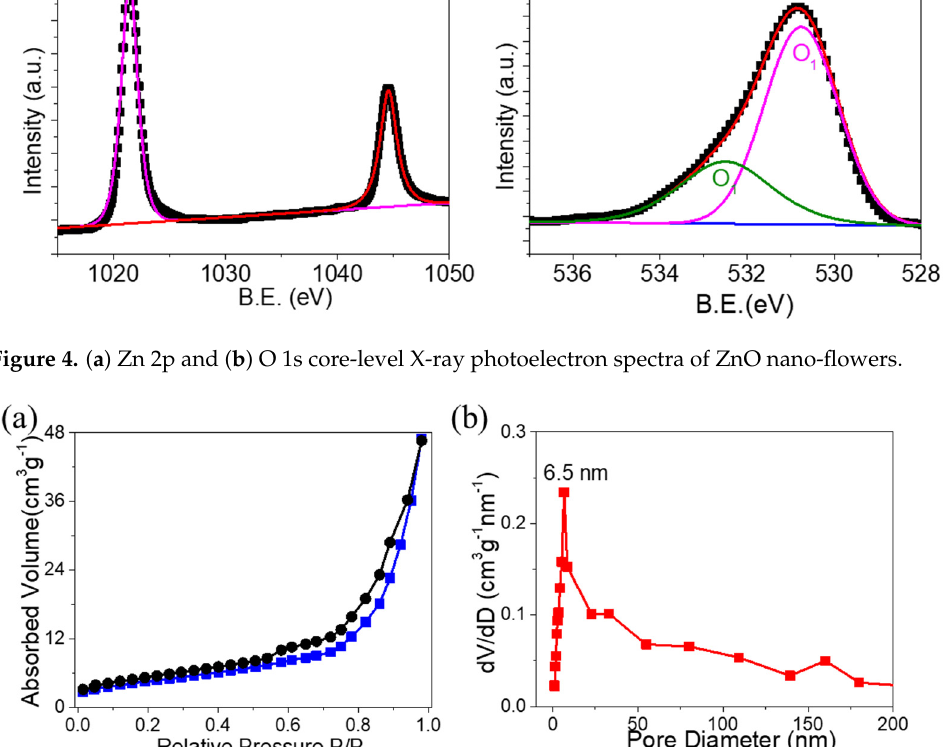
Figure 4. ( a ) Zn 2p and ( b ) O 1s core-level X-ray photoelectron spectra of ZnO nano-flowers.